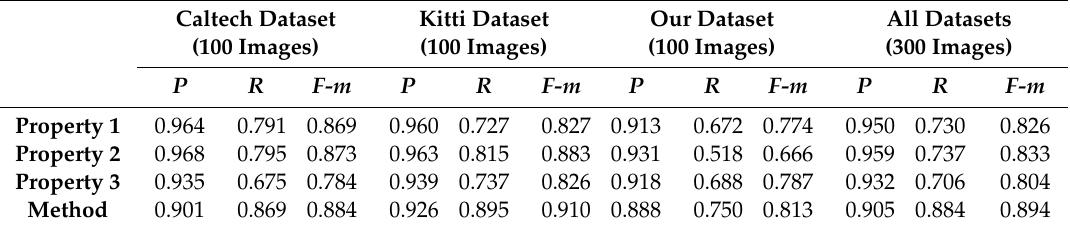
Table 1. Precision ( P ), recall ( R ), and F-measure ( F-m )